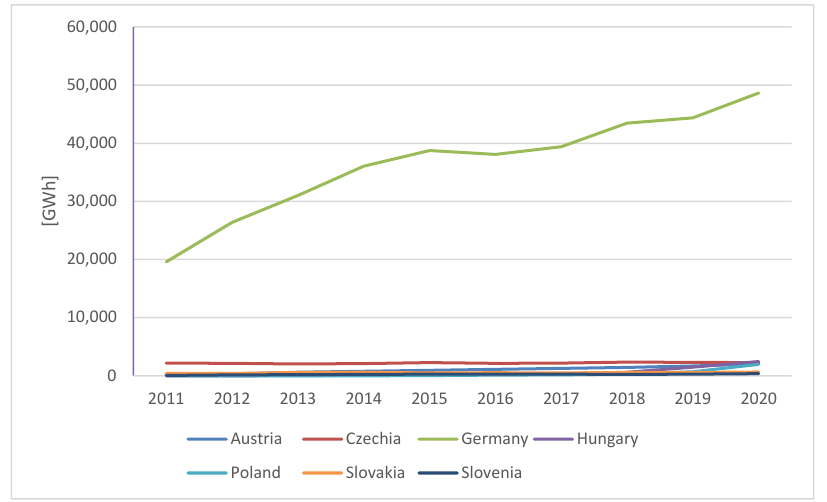
Figure 1. Electricity generation photovoltaics (PV) in Central European countries [30].